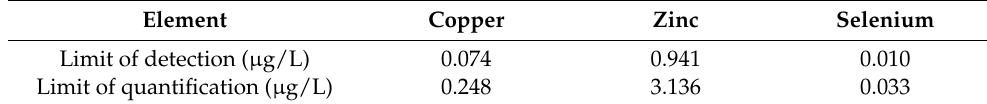
Table A1. Limits of detection (LOD) and quantification (LOQ) for four elements; all values are in µ g/L.